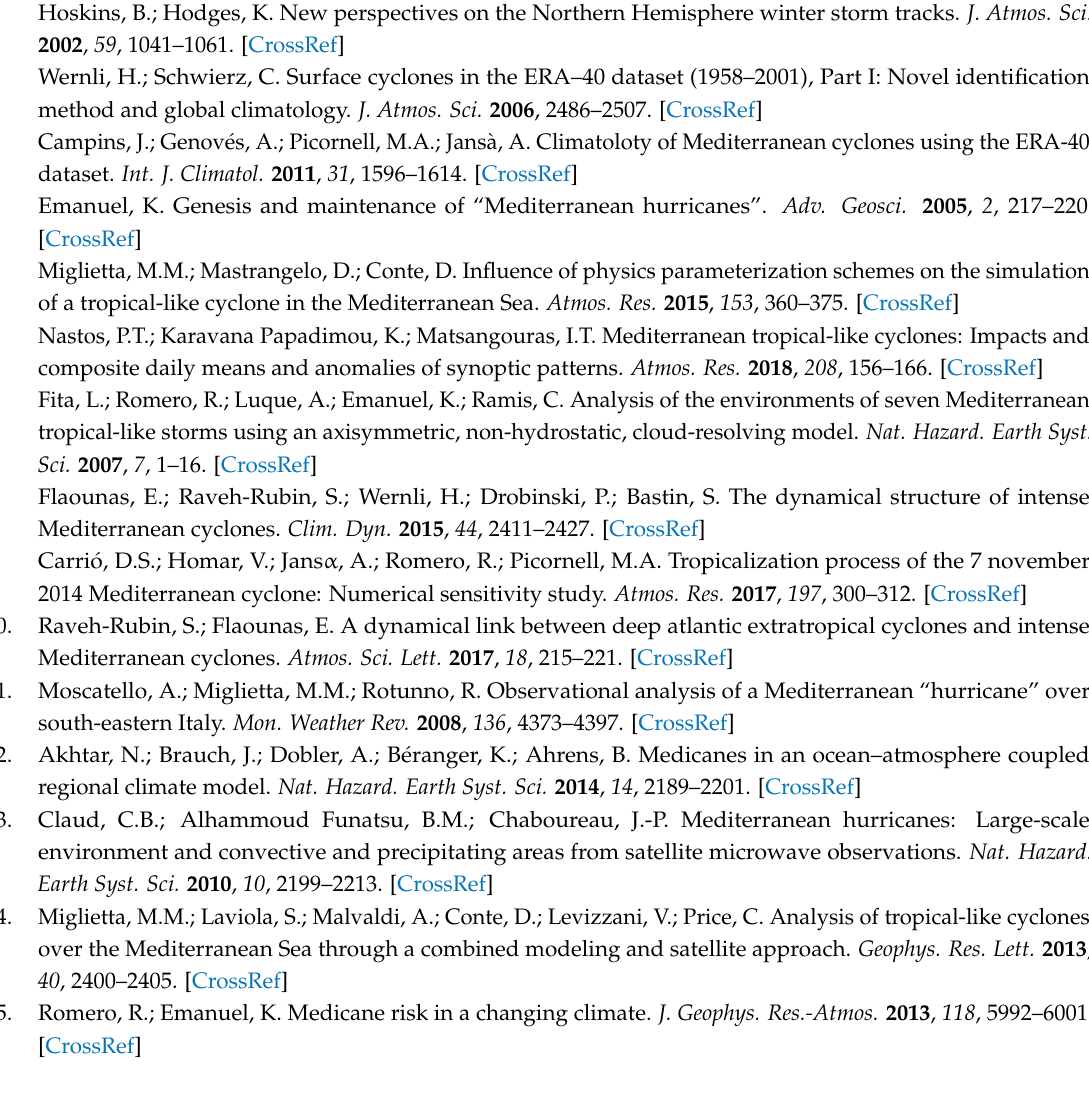
the week after the event and the November climatological mean values.